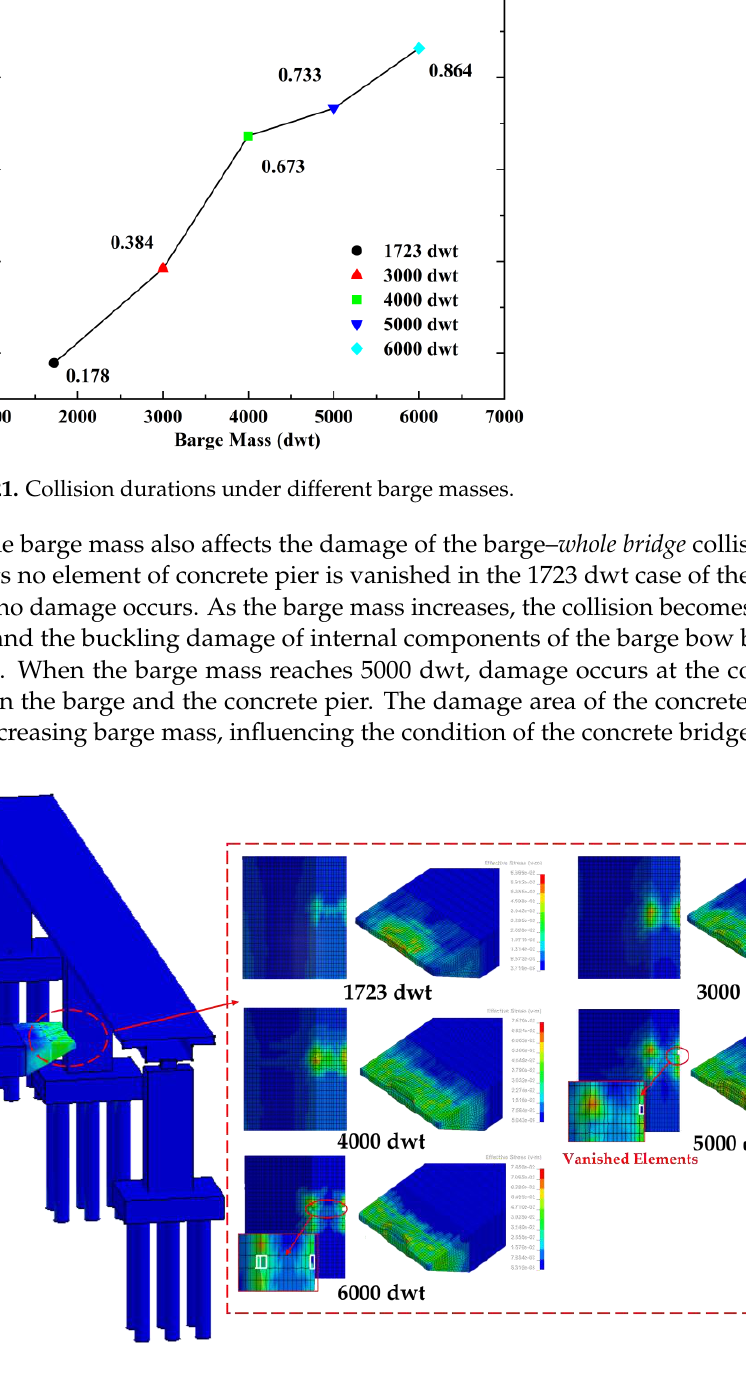
Figure 22. Barge – whole bridge stress nephograms under different barge masses.